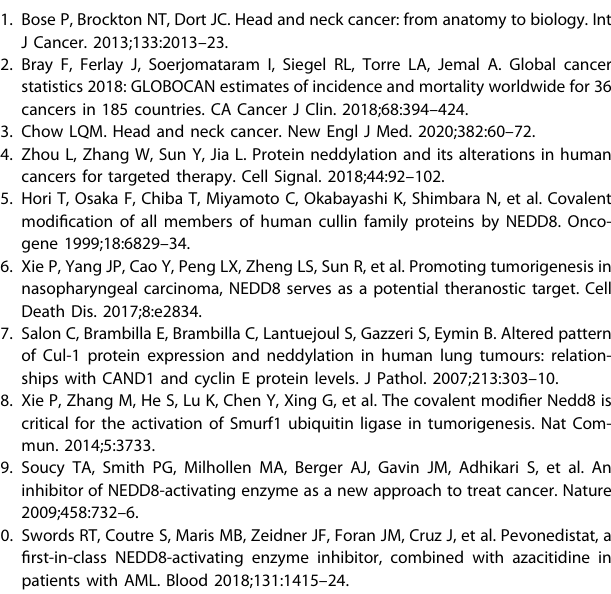
pevonedistat SC QDx5, 3 mg/kg cisplatin IP twice a week, or the combination for approximately 3 weeks. Tumors were measured twice weekly during treatment. Mean ± SEM, n = 10 per group. B The combination of pevonedistat and cisplatin is well-tolerated in mice.